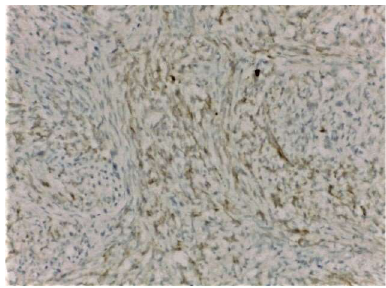
Figure 4. Positive expression of CD 117 in malignant Phyllodes tumor (IHC, x200).